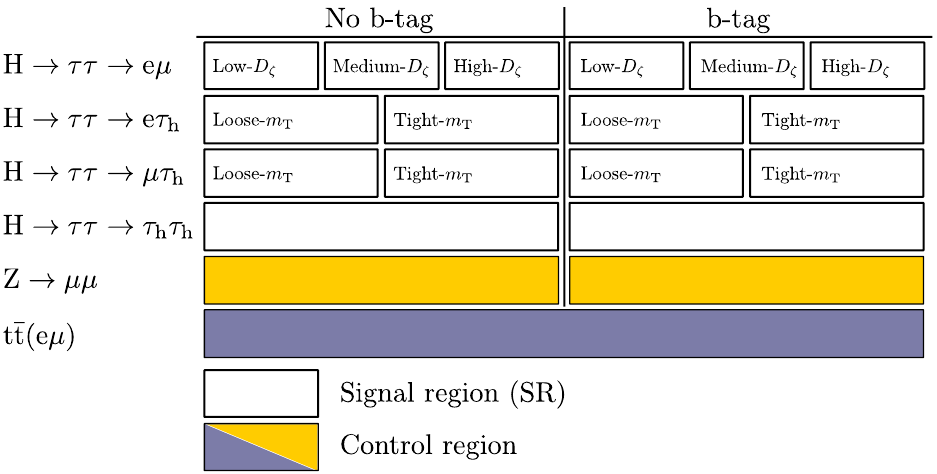
Figure 3 . Overview of all event subcategories that enter the statistical analysis. Sixteen signal categories are complemented by three background control regions in the main analysis as described in section